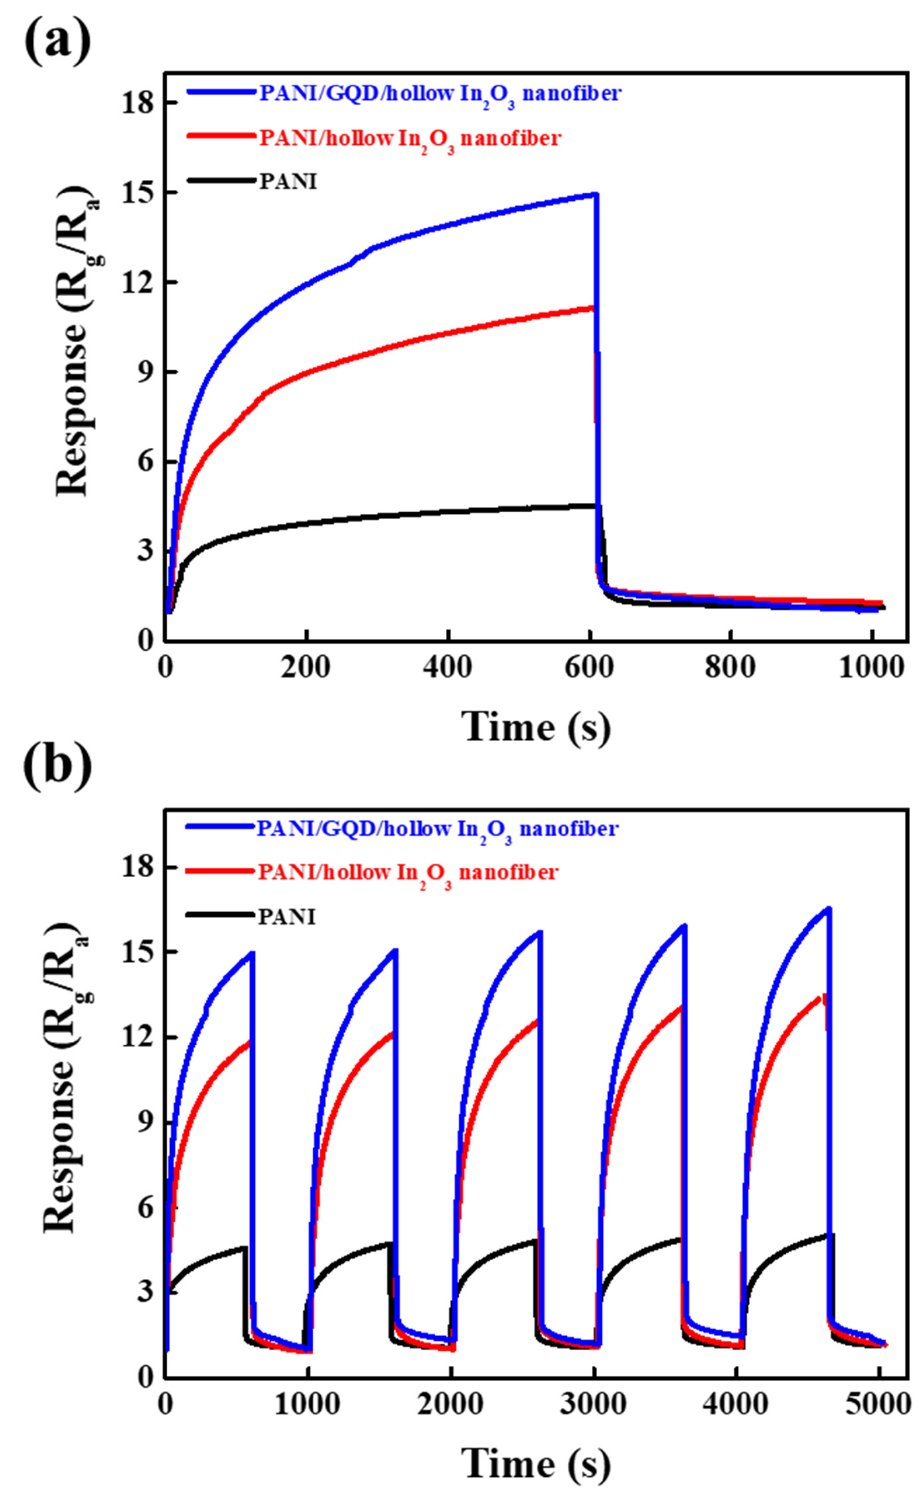
Figure 8. ( a ) The response curves and ( b ) the sensing repeatability and reversibility of neat the PANI polymer matrix, 20 wt% PANI/hollow In 2 O 3 nanofiber, and 20 wt% PANI/GQD/hollow In 2 O 3 nanofiber composites with exposure of 1 ppm NH 3 at room temperature. The PANI/N-GQD/hollow In 2 O 3 nanofiber sensor was applied to detect NH 3 in a concentration ranging from 0.6 ppm to 2.0 ppm at room temperature and to estimate